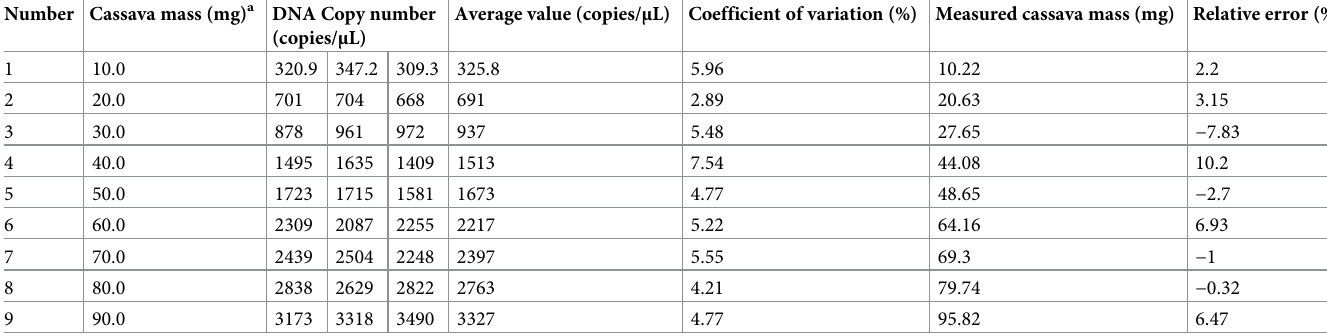
Table 6. Analysis results of cassava with known